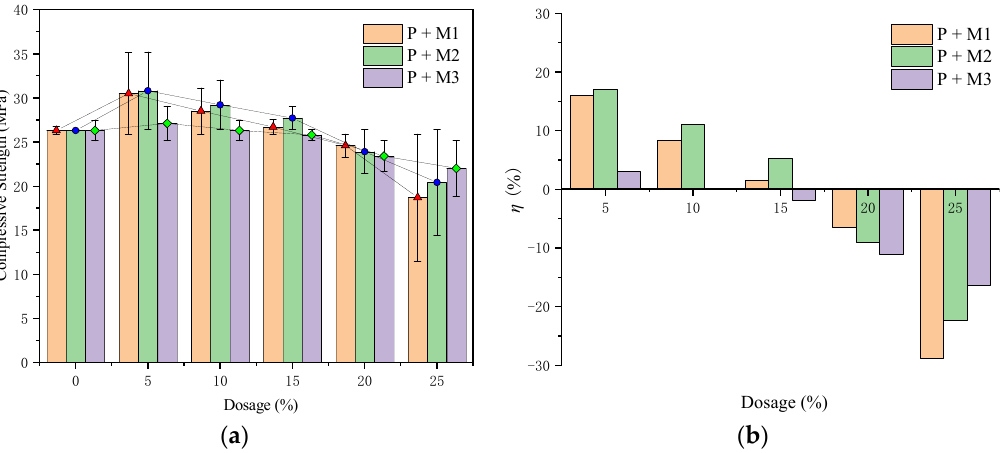
Figure 5. Results of 3 d of compressive strength. ( a ) Compressive strength. ( b ) Efficiency of action.